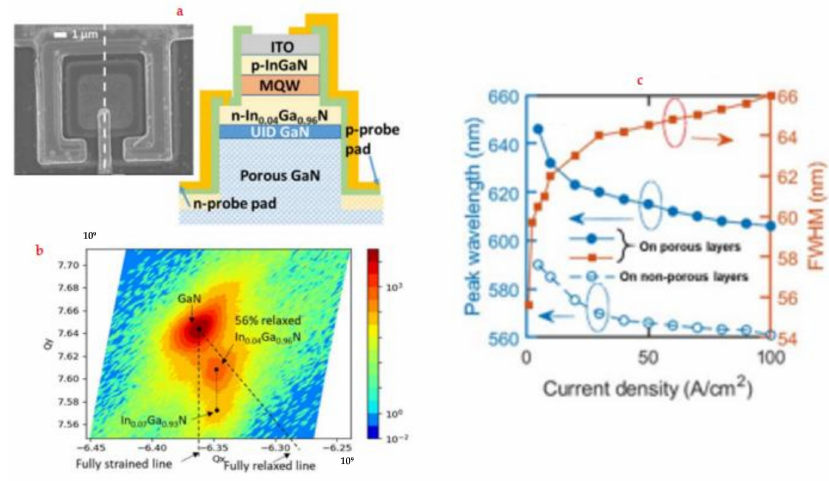
Figure 6. ( a ) Scanning electron microscope of the red µ LED with porous GaN; ( b ) XRD RSM; ( c ) peak wavelength and FWHM vs. J . Copyright 2009 The Japan Society of Applied Physics [20].